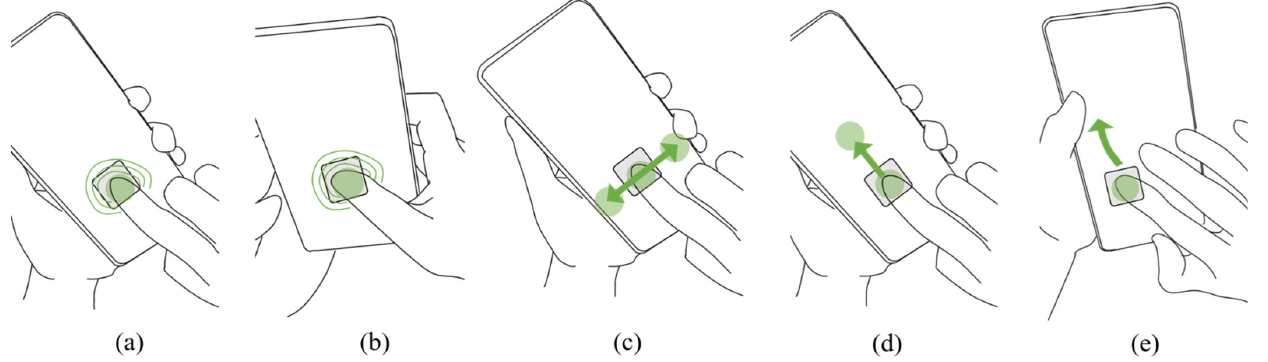
Figure 1. Gestures to trigger vibrotactile stimuli for MST. ( a ) the gesture for “poke”, “tap”, and “tickle”; ( b ) the gesture for “press”; ( c ) the gesture for “nuzzle”, “rub”, “rock”, “shake”, and “tremble”; ( d ) the gesture for “pull”; ( e ) the gesture for “toss”. These gesture figures were selected from [9]. The grey square in Figure 1 represents a graphic button on the touchscreen. Partici- pants started their gestures by pressing the button to trigger the vibrotactile stimuli and continued their gestures until the vibrotactile stimuli